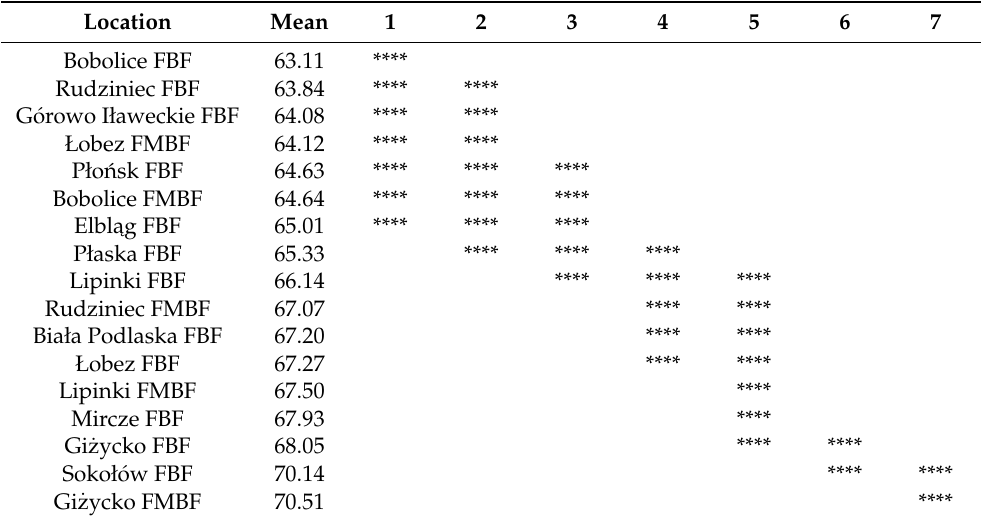
Table 2. Homogeneous groups of locations in terms of mean wood hardness (HSD Tukey’s range